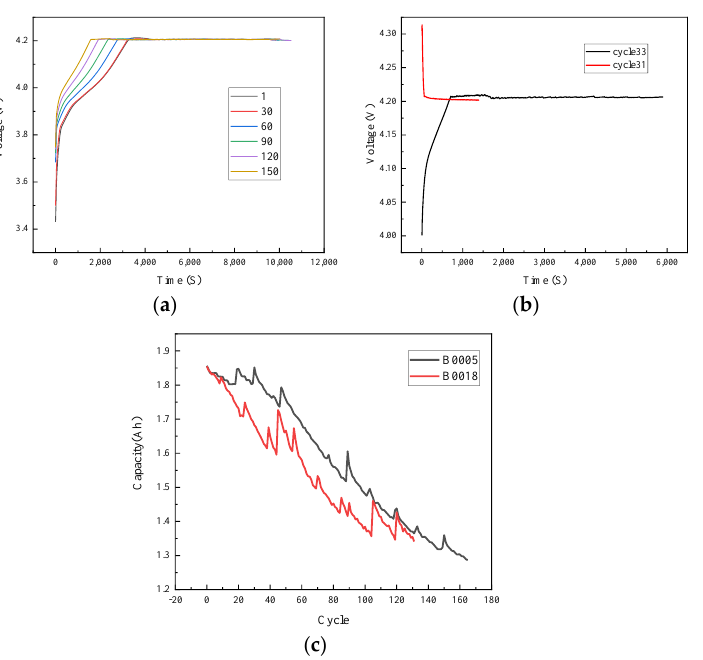
Figure 2. ( a ) Charging voltage curve for different cycles; ( b ) Charging voltage curve and discharge voltage curve; ( c ) Capacity decline curves for different data sets.